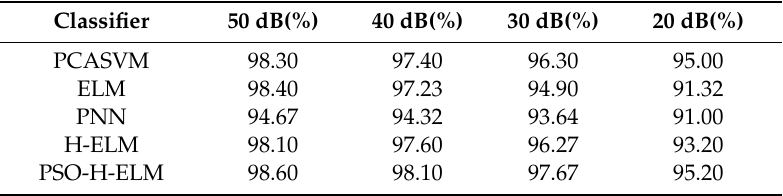
Table 4. Comparison of classification accuracy of five